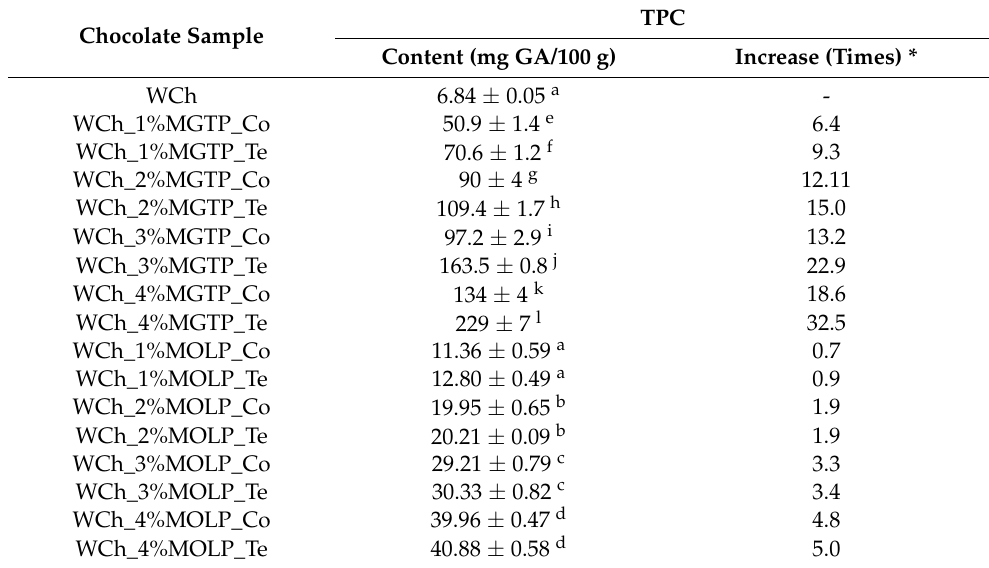
Table 2. Total phenolic content in white chocolate with matcha green tea powder and moringa leaf powder added during conching and